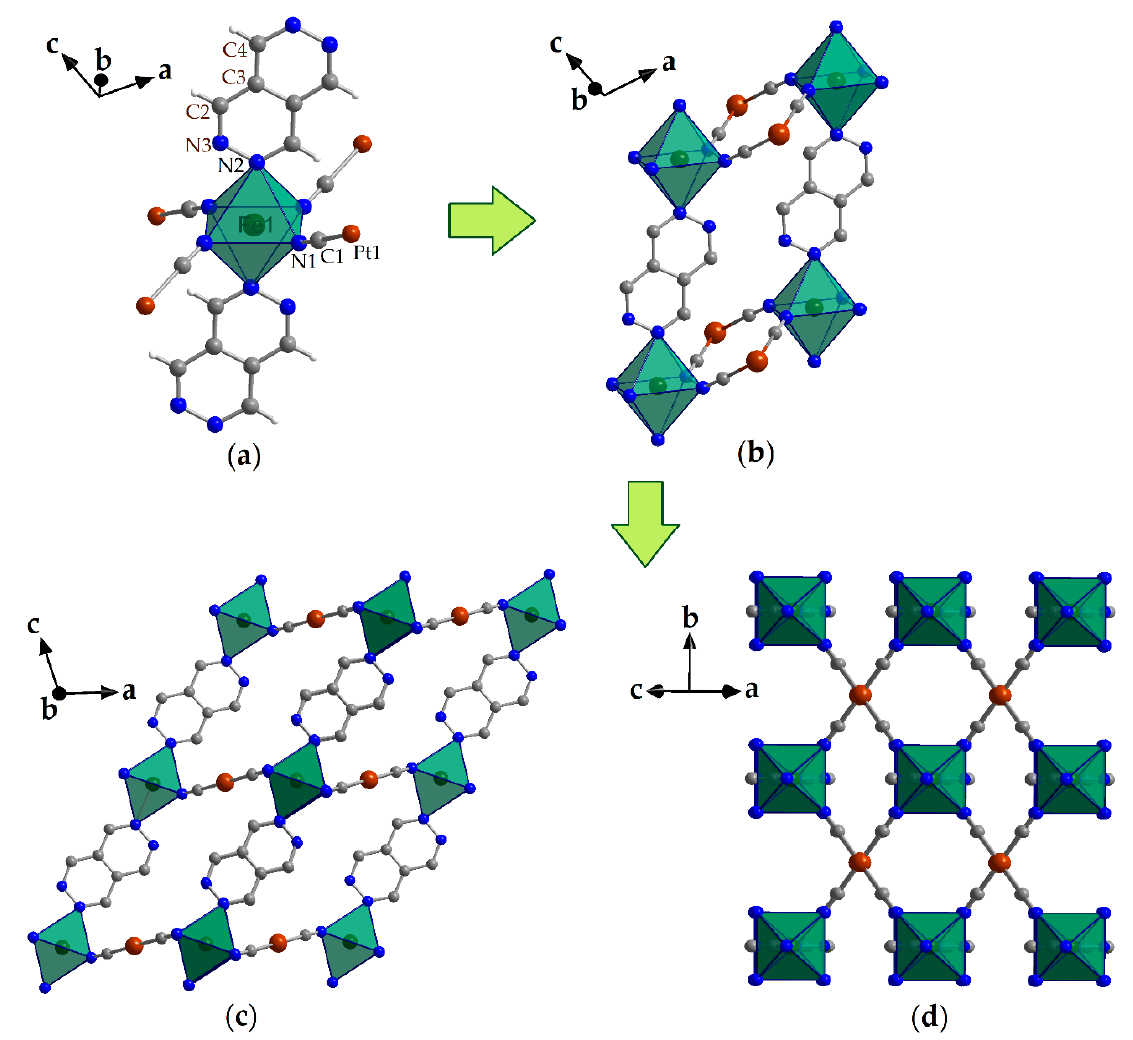
Figure 1. Crystal structure of [Fe( pp )Pt(CN) 4 ] ( 2 ) in the HS state: ( a ) Representation of a key fragment showing the coordination environment of iron(II); ( b ) The basic cavity of the structure; ( c ) View along b direction showing the corrugated cyanometallic layers and pillar coordination of these layers by pp ligands; ( d ) View in ab plane showing the 2D {FePt(CN) 4 } ∞ layer with (4,4)-net topology. Colour code: Fe (olive green), Pt (brown), N (blue), C (gray). Hydrogen atoms in ( b – d ) are omitted for clarity. Guest solvent molecules were removed.